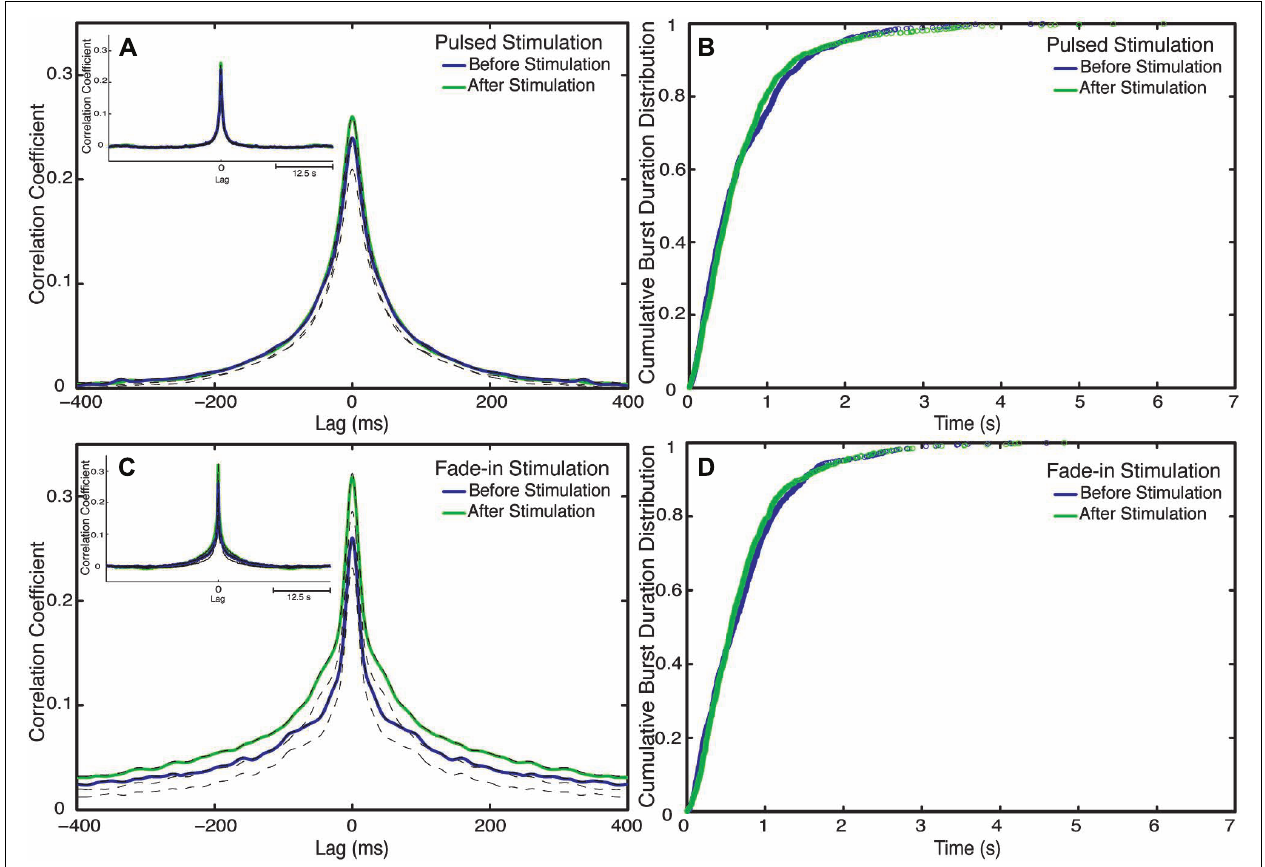
FIGURE 6 | Changes in network synchronization. (A) Average cross- correlation function of pulsed stimulation, with the blue line representing the average cross-correlation function before stimulation and the green line representing the average-cross correlation function after stimulation. Dotted lines mark Jackknife confidence intervals.The inset represents the long-term dynamics of the average cross-correlation function. (B) Cumulative